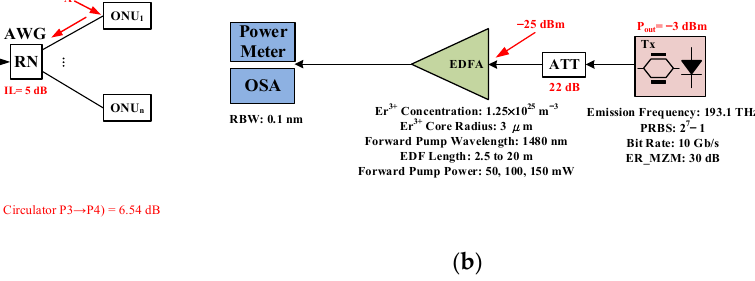
Figure 10. Simulation setup of a backup optical amplifier for ROA 2 : ( a ) detailed setup and ( b ) simplified setup (ATT: attenuator, RBW: resolution bandwidth, OSA: optical spectrum analyzer).